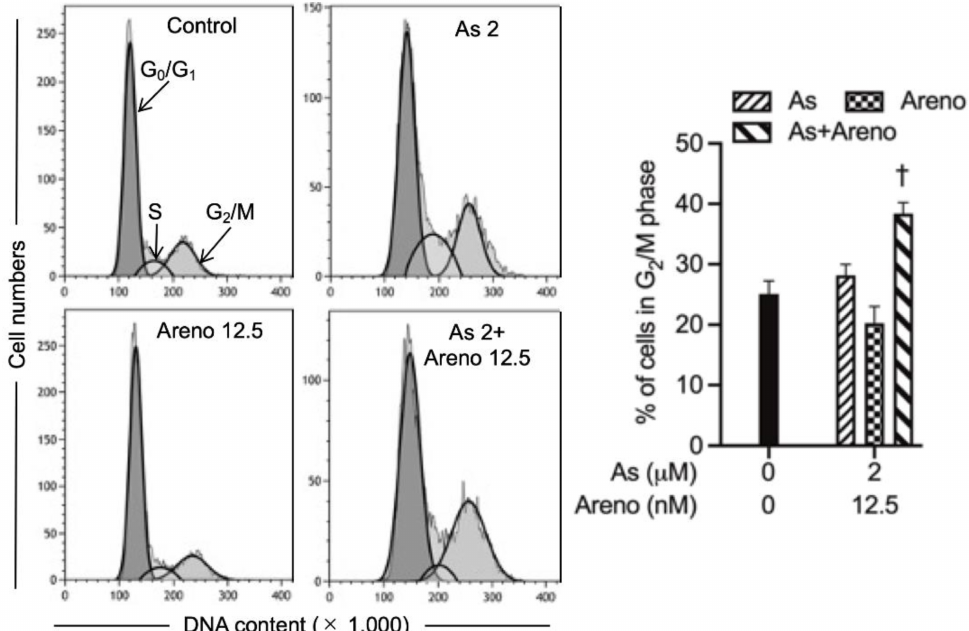
Figure 8. Involvement of G 2 /M arrest in the cytotoxicity of U-87 cells treated with As III combined with arenobufagin. Following treatment with As III (1 and 2 µ M) and arenobufagin (6.25 and 12.5 nM), alone and in combination, for 48 h, cell cycle profiling was performed by CytoFLEX S flow cytometer as described in “Materials and Methods”. Results are shown as the means ± SD from more than three independent experiments. †, p < 0.01 vs. each alone. As, As III ; Areno;